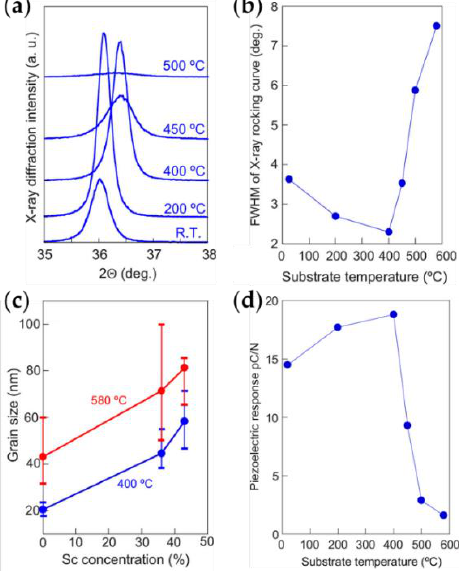
Figure 6. Effect of substrate temperature on ( a ) XRD intensity, ( b ) FWHM, ( c ) grain size, and ( d ) piezoelectric response. Reproduced with permission from Ref. [27].